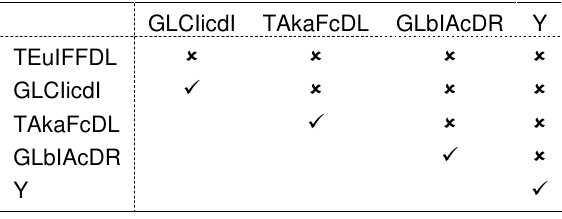
Matrix of Overall Correlation and Probability: MDFV